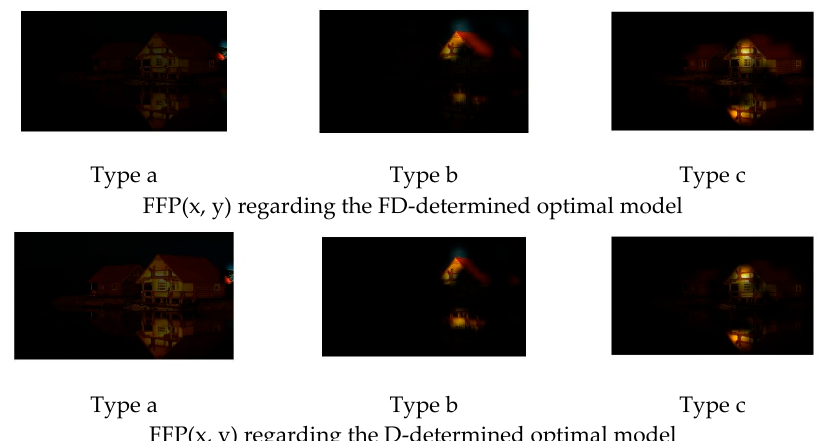
FFP(x, y) regarding the FD-determined optimal model